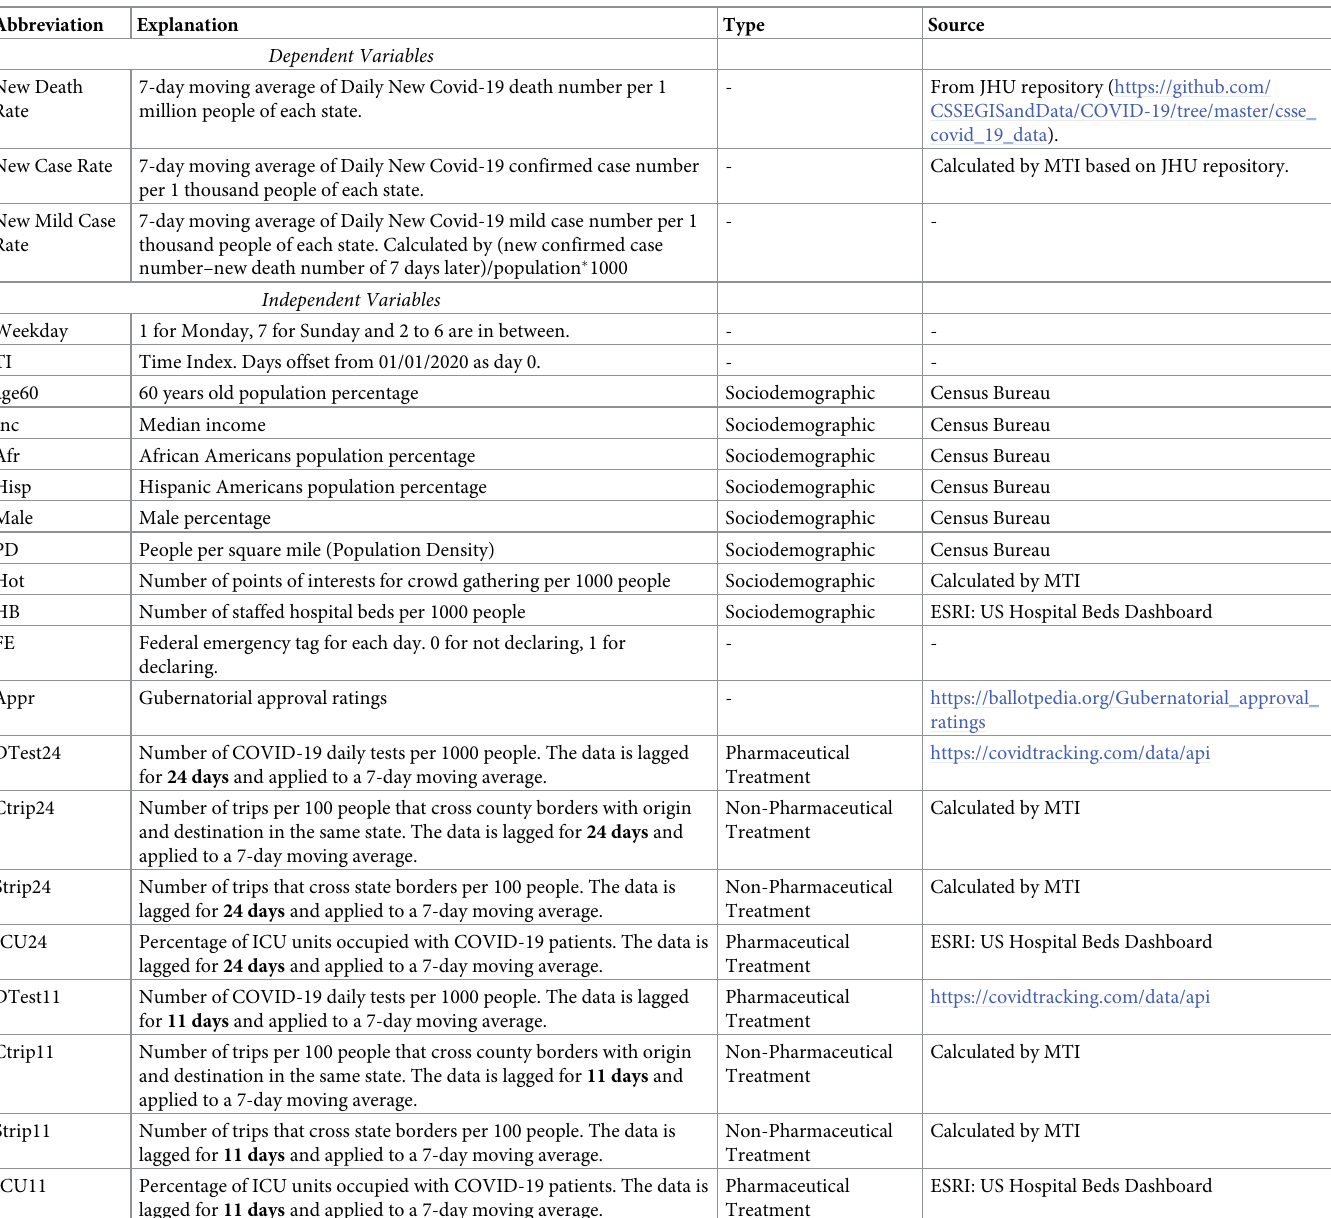
Table 1. Explanation of dependent and independent